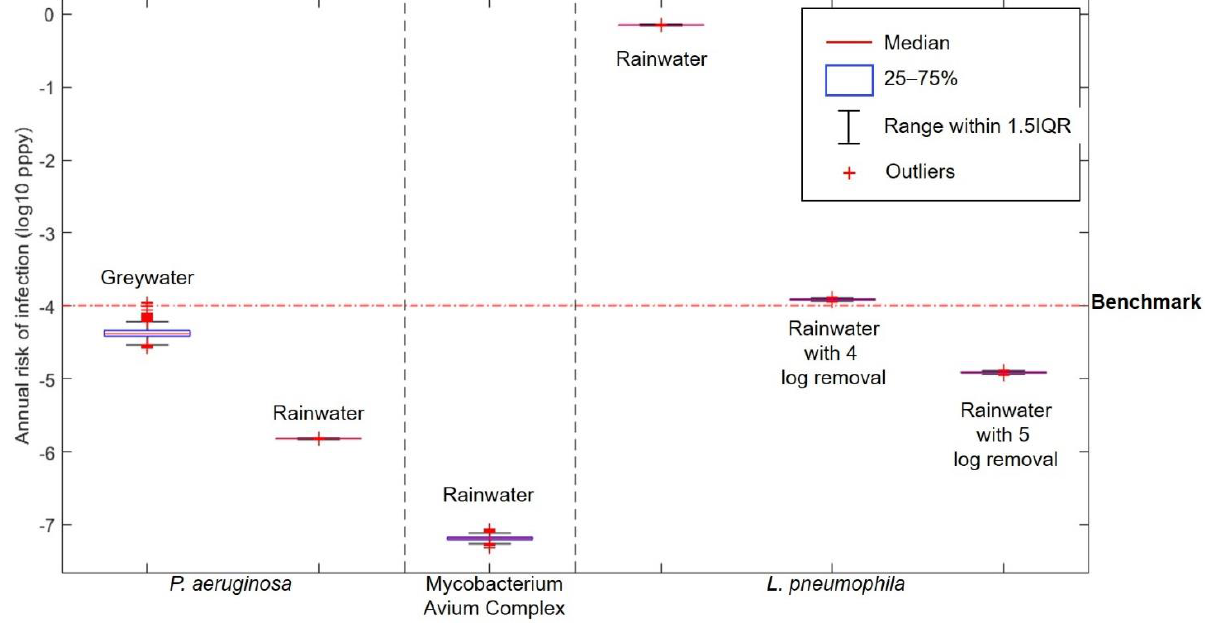
Figure 2. Annual infection risk from toilet flushing.